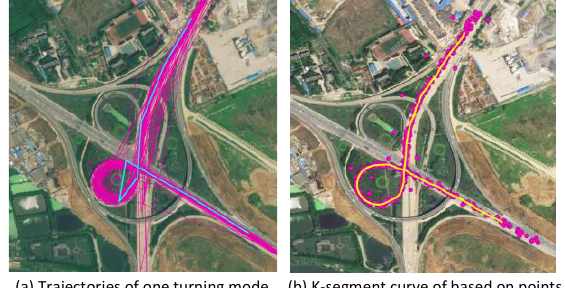
Figure 5. Road intersections with low-frequency sampling tracks of cluster 11(a: Low-frequency trajectories of complex road intersection and its central trajectory; b: Principle curves of tracks) The curves need to be merged after the fitting process of clusters of intersection because the curves are not the